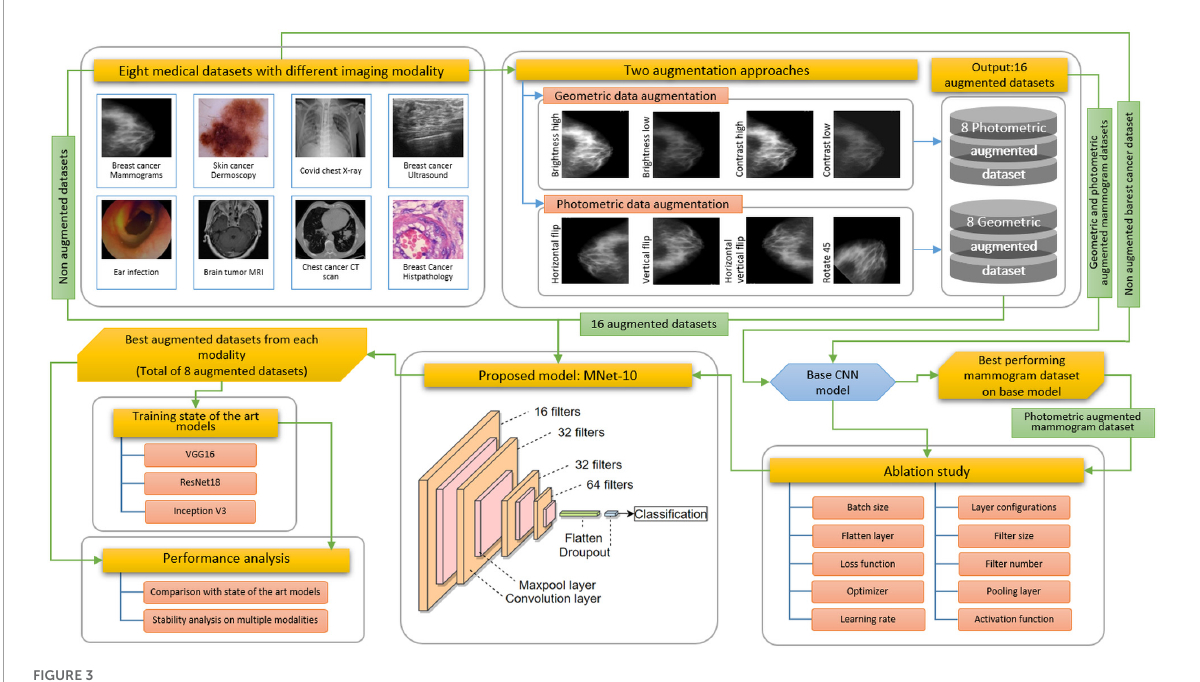
FIGURE3 Overview of the proposed